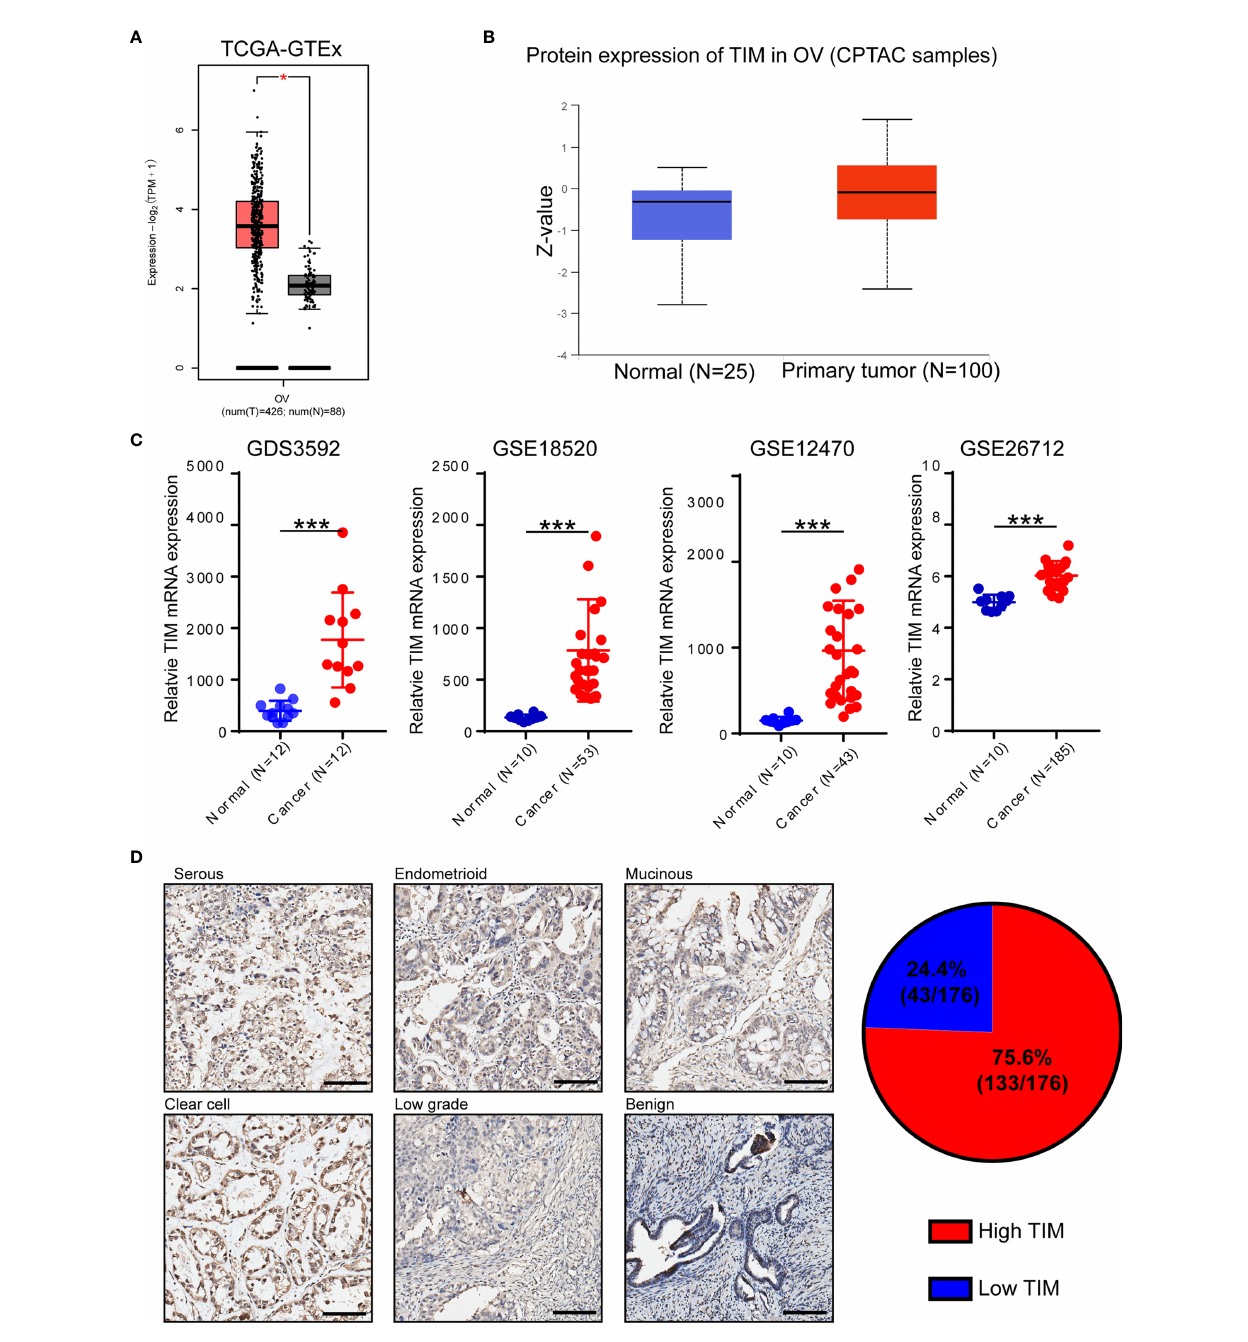
FIGURE 1 | TIM expression is signi fi cantly upregulated in ovarian cancer (OV) patients. (A) Analysis of TIM mRNA expression in OV tissues compared to normal tissue using TCGA database. (B) Analysis of TIM protein expression in OV compared to normal tissue in CPTAC samples. (C) Relative mRNA level of TIM in OV patients using three independent gene expression omnibus (GEO) databases. (D) Left: Representative IHC staining showing the TIM expression in different types of ovarian cancer specimens as well as in benign ovarian cancer. Scale bar = 100 m m. Right: Graphical analyses showing the percentage of high/low expression of TIM level in a total of 176 OV patients. *p < 0.05, ***p <